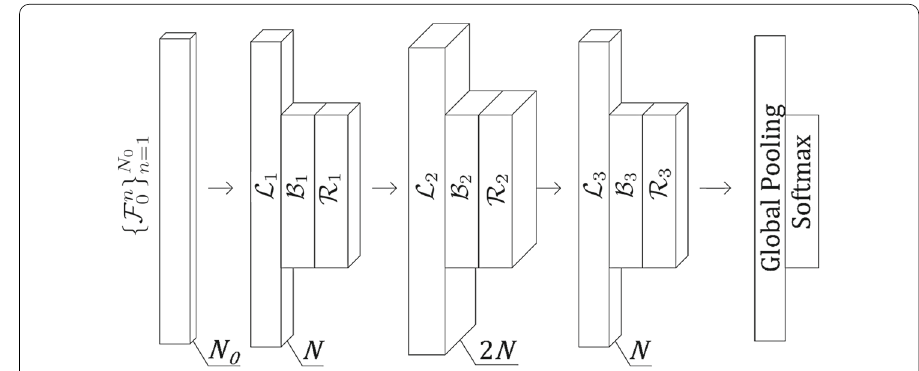
Fig. 2 FCN architecture in the case of a single data type. Here N 0 represents the number of input channels and N represents the adopted number of filters. For sake of clarity, the dimensionality of the building blocks has been enhanced: a three-dimensional parallelepiped is used to depict the two-dimensional output of each convolutional layer; a two-dimensional rectangle is used to depict the one-dimensional output of the global pooling layer and of the softmax